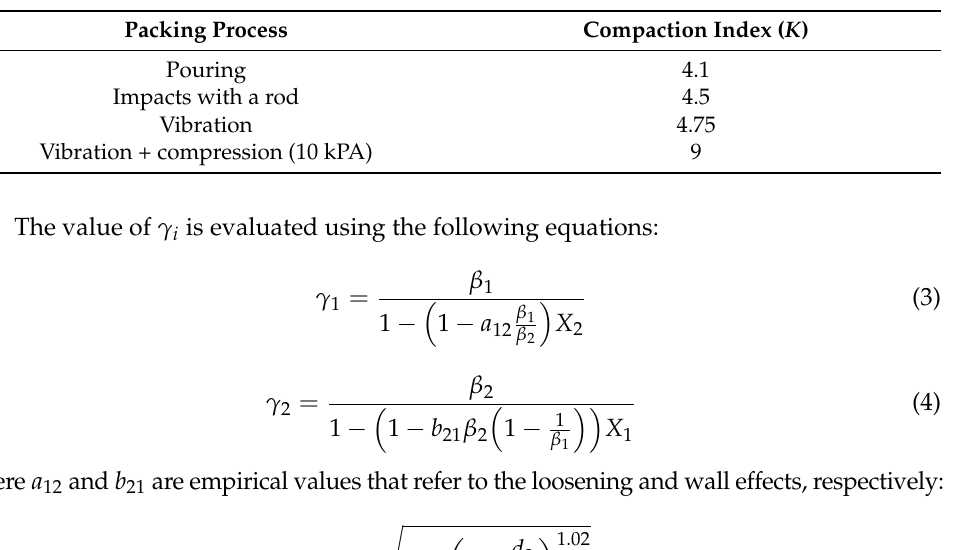
Table 1. Values of compaction index K assigned to different packing processes [23].